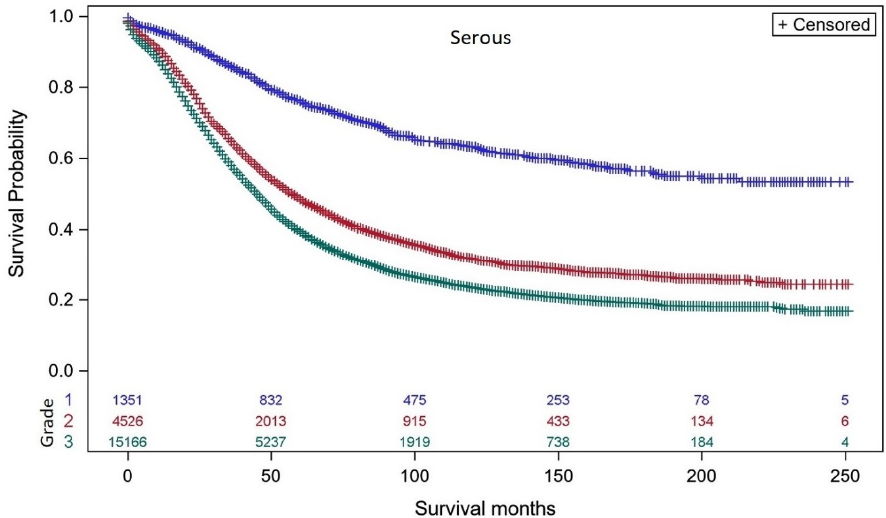
Figure 1. Kaplan–Meier ovarian cancer-specific survival showing number of women at risk according to grade of serous EOC (8441/3, 8460/3, 8461/3). Women with grade 1 well differentiated serous EOC (blue curve, n = 1,351; 50, 100 & 200-month survival is 80.0%, 66.2%, 55.0%), grade 2 moderately differentiated (red curve, n = 4,526; 50, 100 & 200-month survival is 55.8%, 36.5%, 25.7%), and grade 3 undifferentiated (green curve, n = 15,166; 50, 100 & 200-month survival is 48.3%, 27.7%, 19.0%). The number of women remaining at different survival points is shown for well differentiated screened (blue), moderately differentiated (red), undifferentiated (green) cases. Log-rank test p < 0.001.